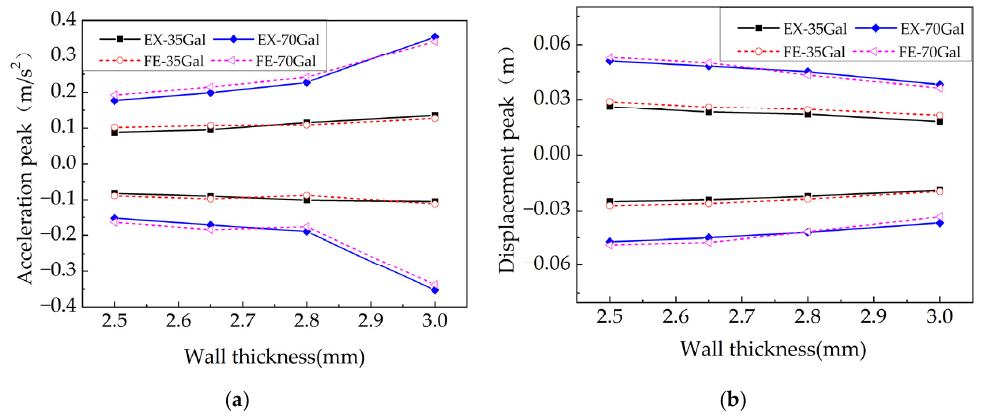
Figure 33. Comparison under the Nihonkai-Chubu earthquake: ( a ) Comparison of acceleration peak; ( b ) Comparison of displacement peak.